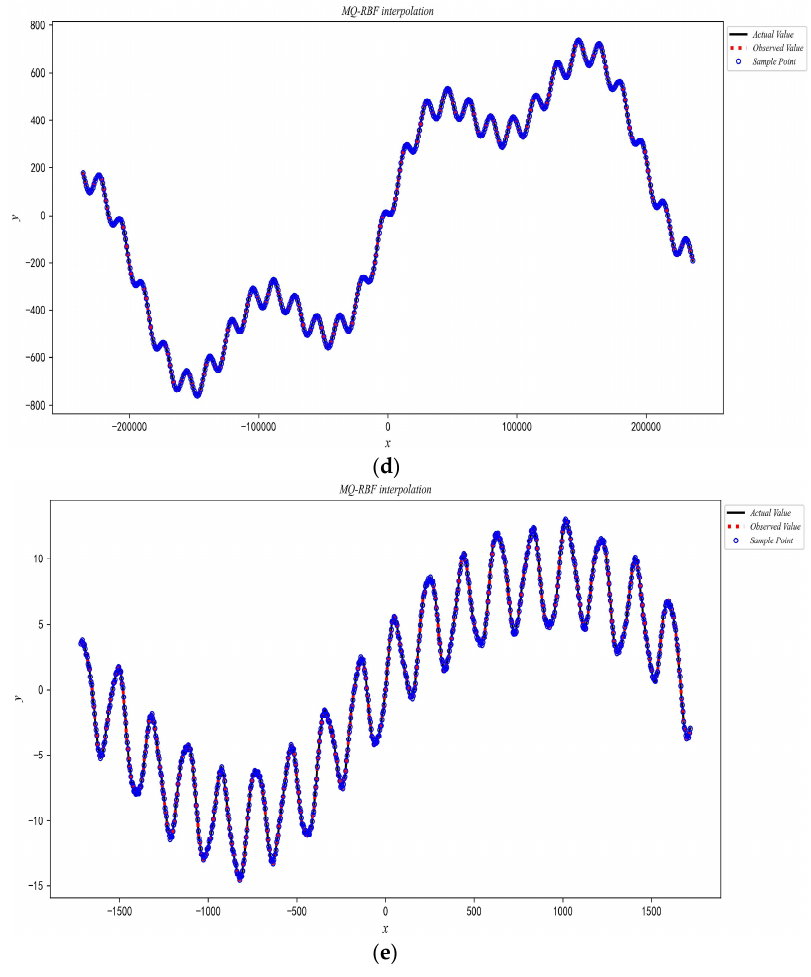
Figure 6. Interpolation e ff ect diagram of multi-frequency sine signal: ( a ) Function (13); ( b ) Function (14); ( c ) Function (15); ( d ) Function (16); ( e ) Function (17).